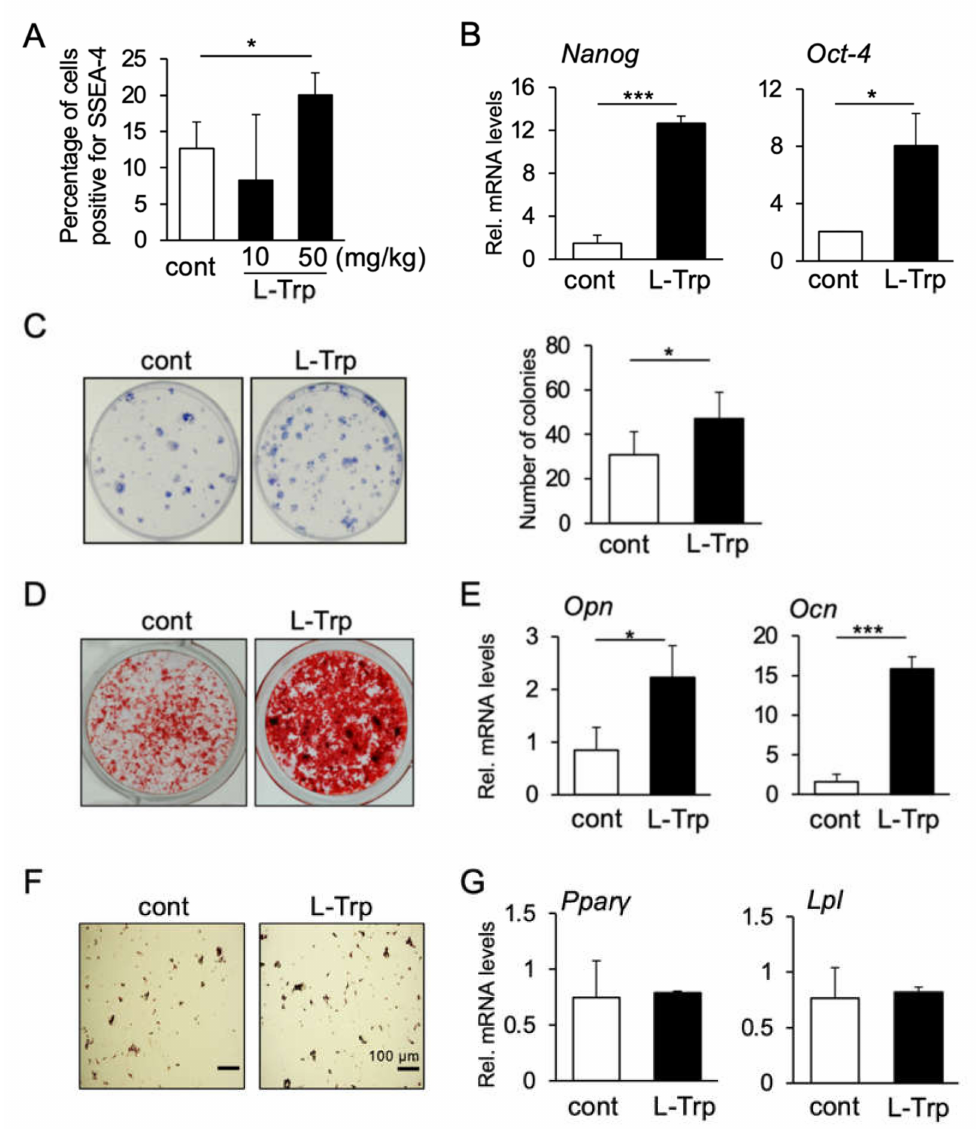
Figure 3. Effect of L-tryptophan on the stem cell phenotype of mBMSCs and trabecular bone in vivo. ( A ) FCM analysis of the percentage of mBMSCs positive for SSEA-4. mBMSCs from L-Trp (50 mg/kg)-treated mice showed a significantly higher number of SSEA-4 positive cells than the control group. * p < 0.05, one-way ANOVA/Turkey. ( B ) Gene expression levels of Nanog and Oct-4 in mBMSCs from 50 mg/kg L-Trp-treated mice was significantly higher than mBMSCs from the PBS-injected control group. Data represent the mean ± SD (n = 3). * p < 0.05, *** p < 0.001, unpaired t -test. ( C ) Treatment with L-Trp increased the colony-forming ability of mBMSCs. Data represent the mean ± SD (n = 3). * p < 0.05, unpaired t -test. ( D , E ) Differentiation ability. L-Trp induced stronger deposition of the calcified matrix as detected by Alizarin Red S staining ( D ) as well as an increase in the mRNA levels of Opn and Ocn on mBMSCs ( E ). No substantial change in Oil Red O staining ( F ) or gene expression levels of Ppar- γ or Lpl ( G ) could be observed upon L-Trp treatment. * p < 0.05, *** p < 0.001, unpaired test. Images and graphs are representative of at least three independent